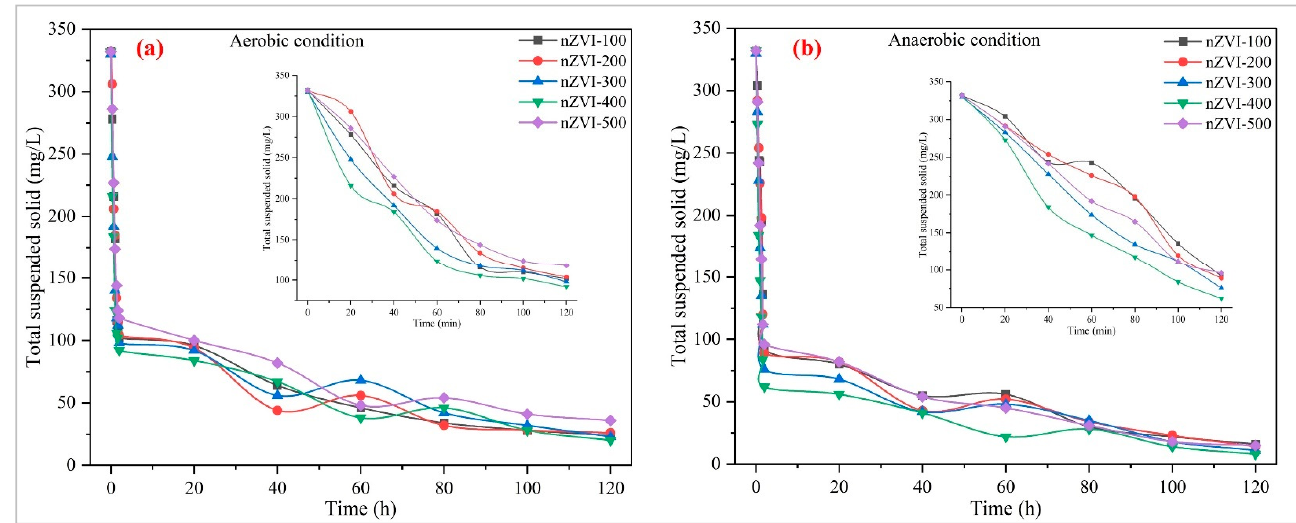
Figure 7. TSS reduction at a different dosage of nZVI and conditions: ( a ) aerobic; the first 120 min of the aerobic treatment (inset) ( b ) anaerobic; the first 120 min of the anaerobic treatment (inset).